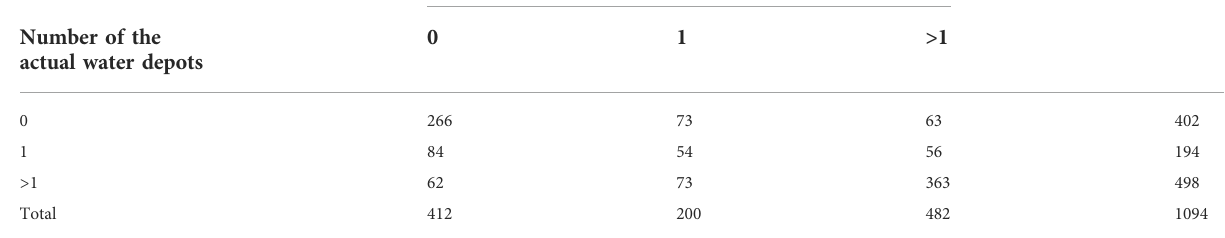
TABLE 3 The cells with different numbers of the actual and model-simulated water depots ( κ =